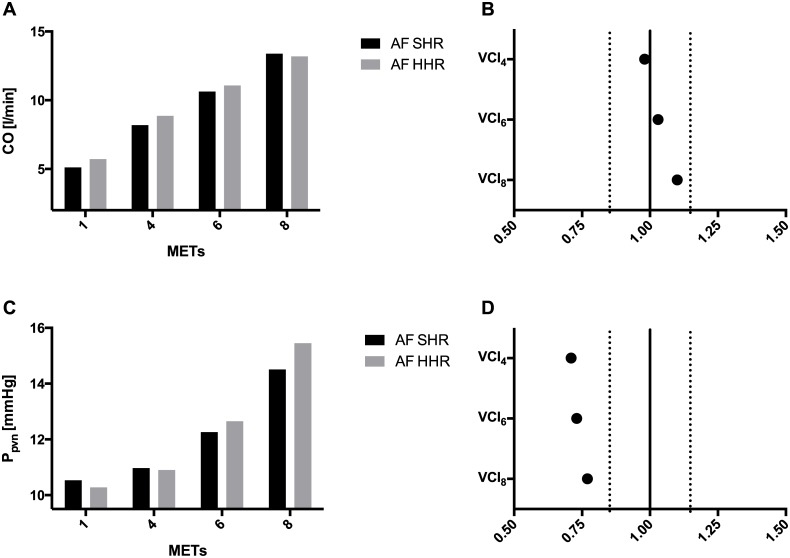
Mean values and VCIs for cardiac output (CO) and pulmonary venous pressure (Ppvn).(A) Mean CO as function of exercise intensity in SHR and HHR simulations. (B) Plot of the VCIs calculated for CO. (C) Mean Ppvn as function of exercise intensity in SRH and HHR simulations. (D) Plot of the VCIs calculated for Ppvn. In plot B and D, the solid line intercepts VCI axis at 1, while the two dashed lines intercept VCI axis at 0.85 and 1.15 (pre-defined cut-off between relevant, i.e. VCI ≥ 1.15 and ≤ 0.85, and not relevant variations, i.e. 1.15 > VCI > 0.85); with respect to 1 MET simulation value, black dot indicates that the variable increases both in SHR and HHR exercise simulations.